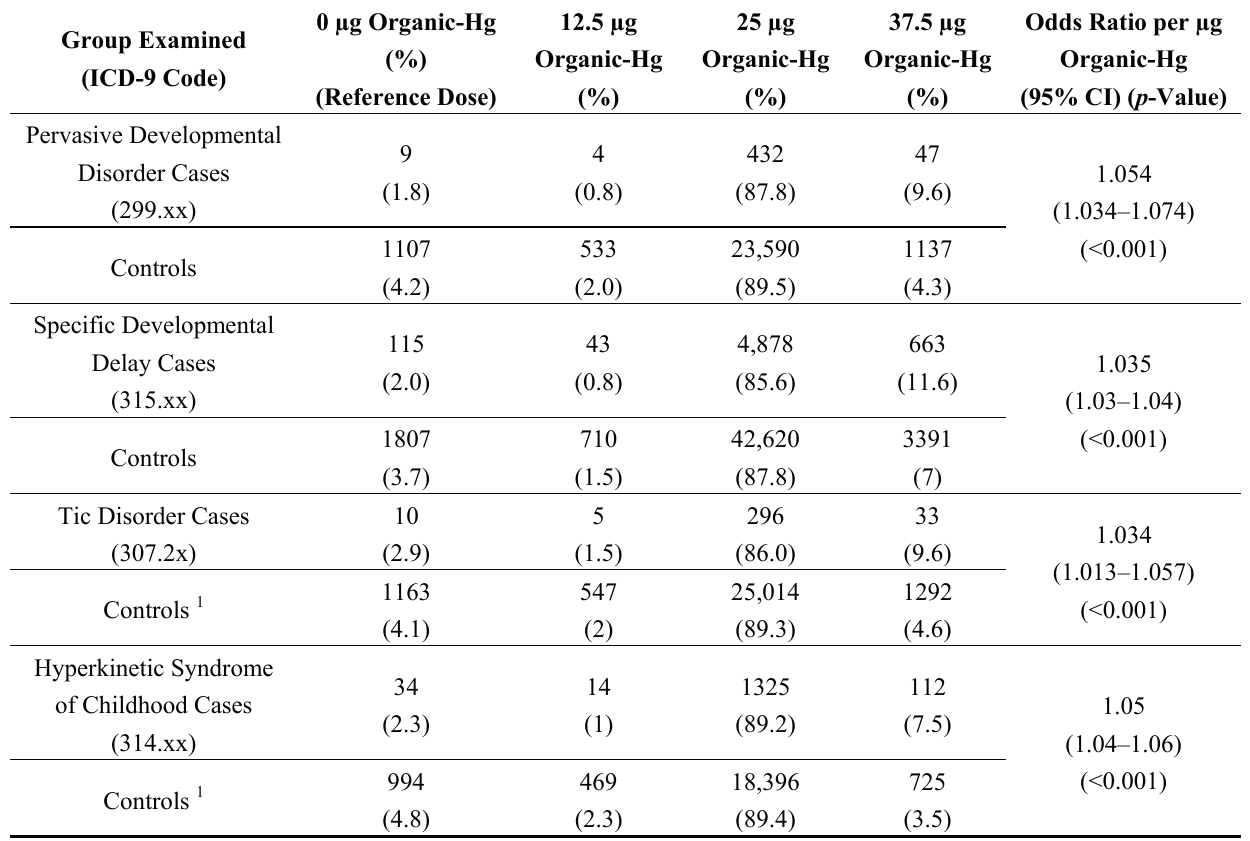
Table 2. A summary of exposure to organic-Hg from thimerosal-containing hepatitis B vaccine administration within the first six months of life for the cases diagnosed with a studied neurodevelopmental disorder (ND) and